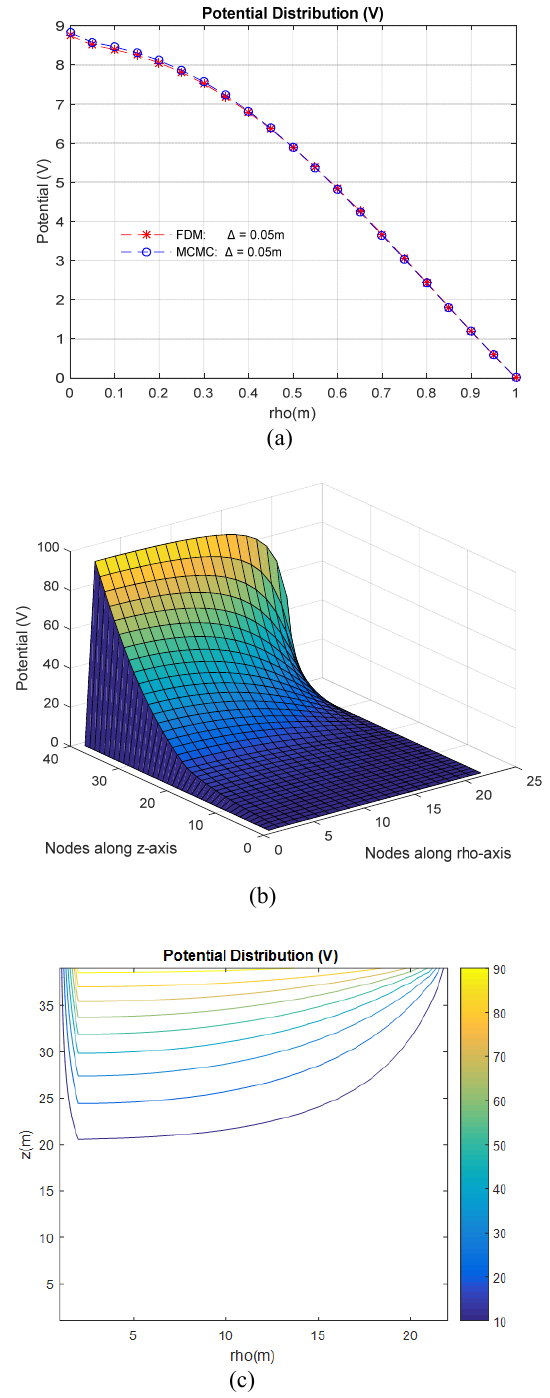
Figure 5. Potential Distribution along (a) m101z   , (media interface), (b) Surface Plot (c) Contour Plot for Axisymmetric Inhomogeneous Problem with constant boundary potentials.